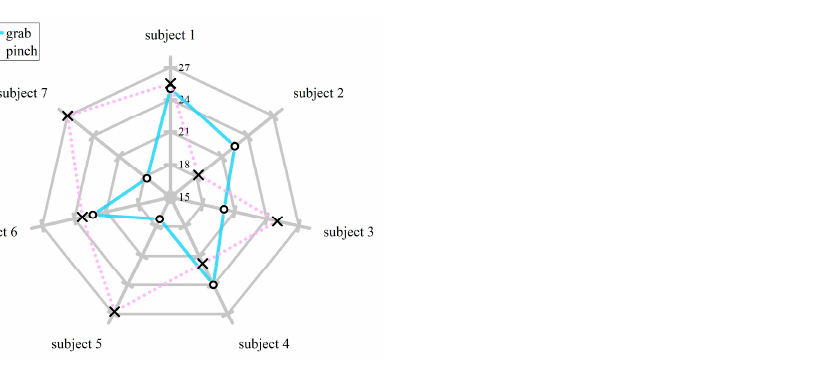
Figure 10. The average number of interaction predictions, with respect to gesture, for each subject.